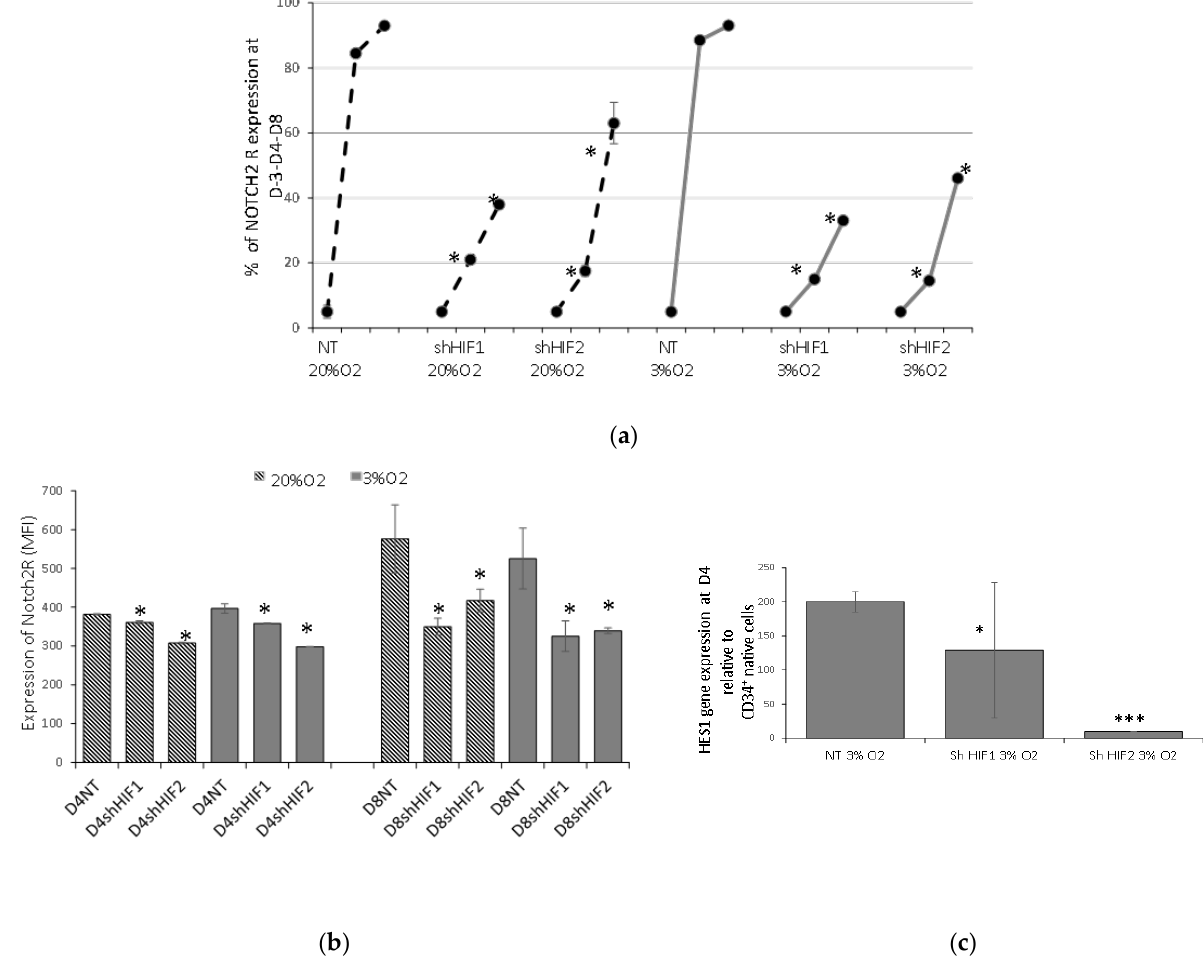
Figure 5. Notch/HIF interplay in early erythroid development. ( a ) The expression of Notch2 receptors in the cells harvested at the beginning (Day 3, D-3), Day 4 (D 4) and Day 8 (D 8) of eight-day erythroid cultures. The curves represent the average percentage of receptor expression in whole culture. ( b ) The bars show average mean fluorescence intensity. Data are presented as mean values ± SD of 4 independent experiments. ( c ) The expression of Notch target gene HES1 was evaluated in erythroid cells obtained at Day 4 of culture of non-transduced CD34 + cells as well as transduced CD34 + cells with shHIF1α or with shHIF2α at 20 and 3% O 2 by real-time polymerase chain reaction analysis. Bars represent relative gene expression with respect to native CB CD34 + cells. Data are shown as mean ± SD of five independent experiments. The asterisks indicate a significant difference with respect to NT condition at p < 0.05 (*), p < 0.001 (***), Mann – Whitney test. NT, non-transduced CD34 + cells; D, day of culture .